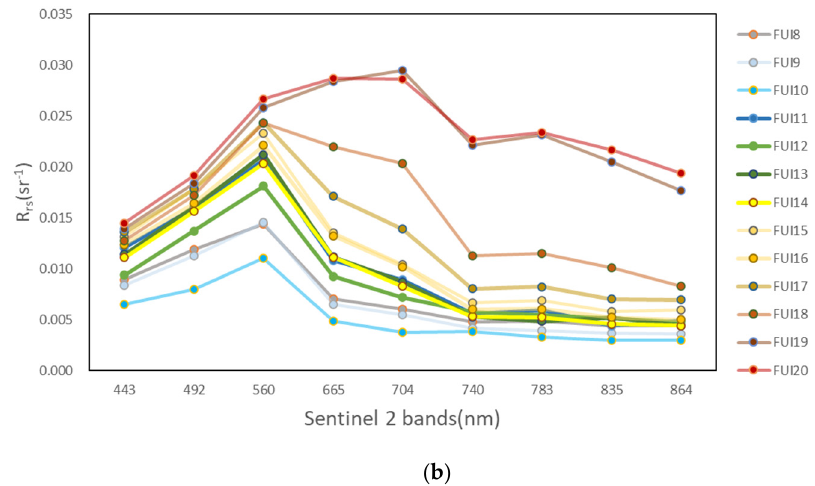
Figure 2. ( a ) In situ remote sensing reflectance R rs ( λ ) in 2018–2020. ( b ) The spectral reflectance of simultaneous Sentinel-2. Figure 3 shows the deviation Δα from the hyperspectral hue angle for Sen- tinel-2 MSI. At the horizontal axis, this sensor hue angle is plotted. At the vertical axis, Δα is pro- vided. The variation range of α hyper is between 40° and 80°, and the independent variable x is defined as the hue angle α hyper of Sentinel-2 sensor divided by 100. The offset Δα reached the lowest value near α hyper = 65 ° , and then gradually increased with the increase in hue angle α hyper. The curve shape is approximate to the U–shaped curve, which can be expressed by the fifth- order polynomial.